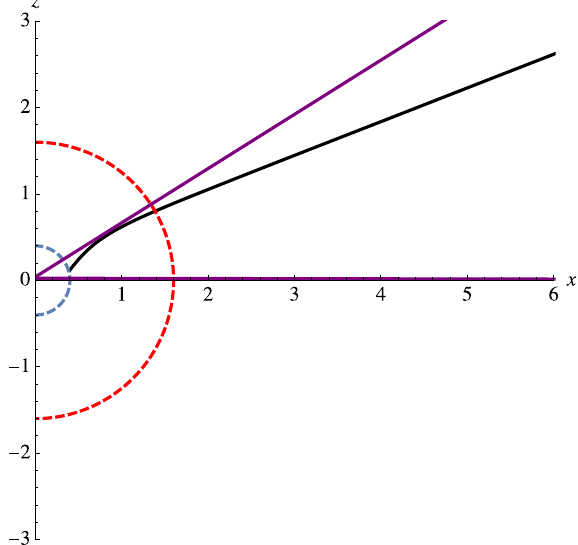
Fig. 10 The capturing trajectory for the case of ˜ η = 0, inside the cone √ of confinement, plotted for ω 0 = 10 . 30. The outer and inner circles indicate, respectively, r + and r −